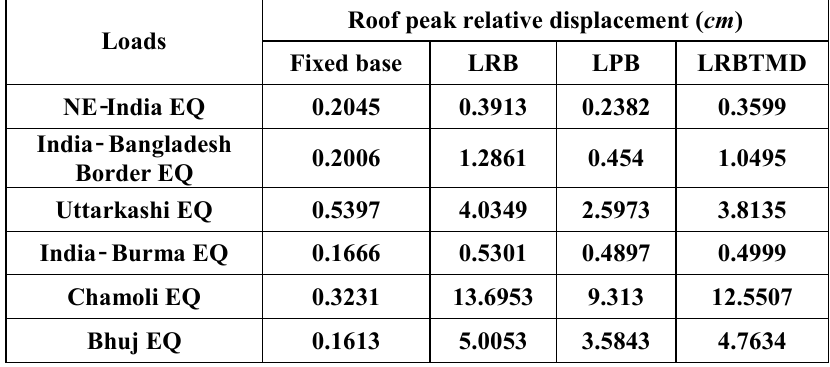
Roof peak relative displacement under